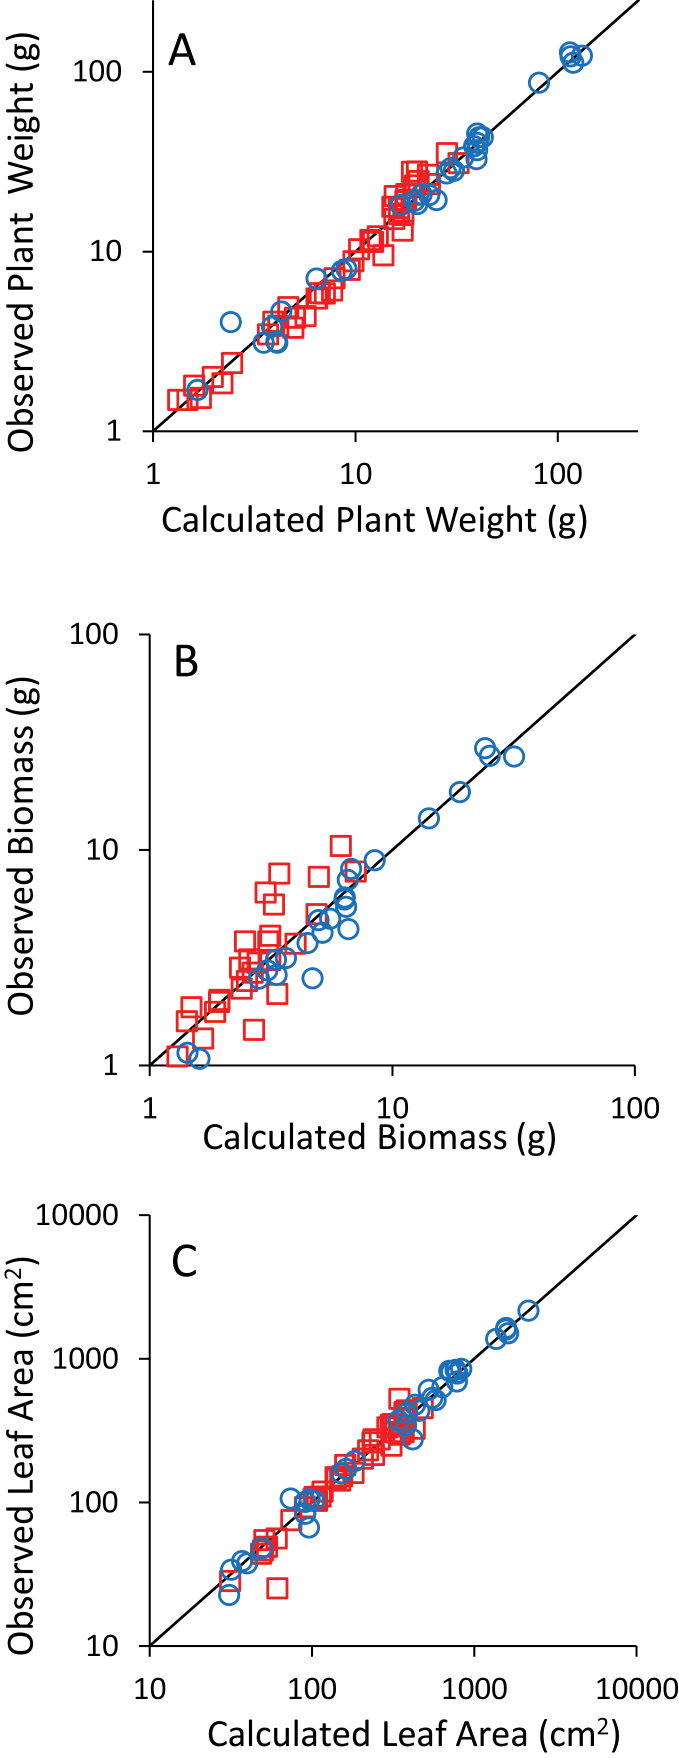
Plots of observed/calculated variables for Plant weight (A), Biomass (B), and Leaf area (C). Circles are data for well-watered plants and squares are for drought-stressed plants. The line is the 1:1 line. The scale is logarithmic for better data visualization but models were selected on raw data. (This figure is available in colour at JXB online.)